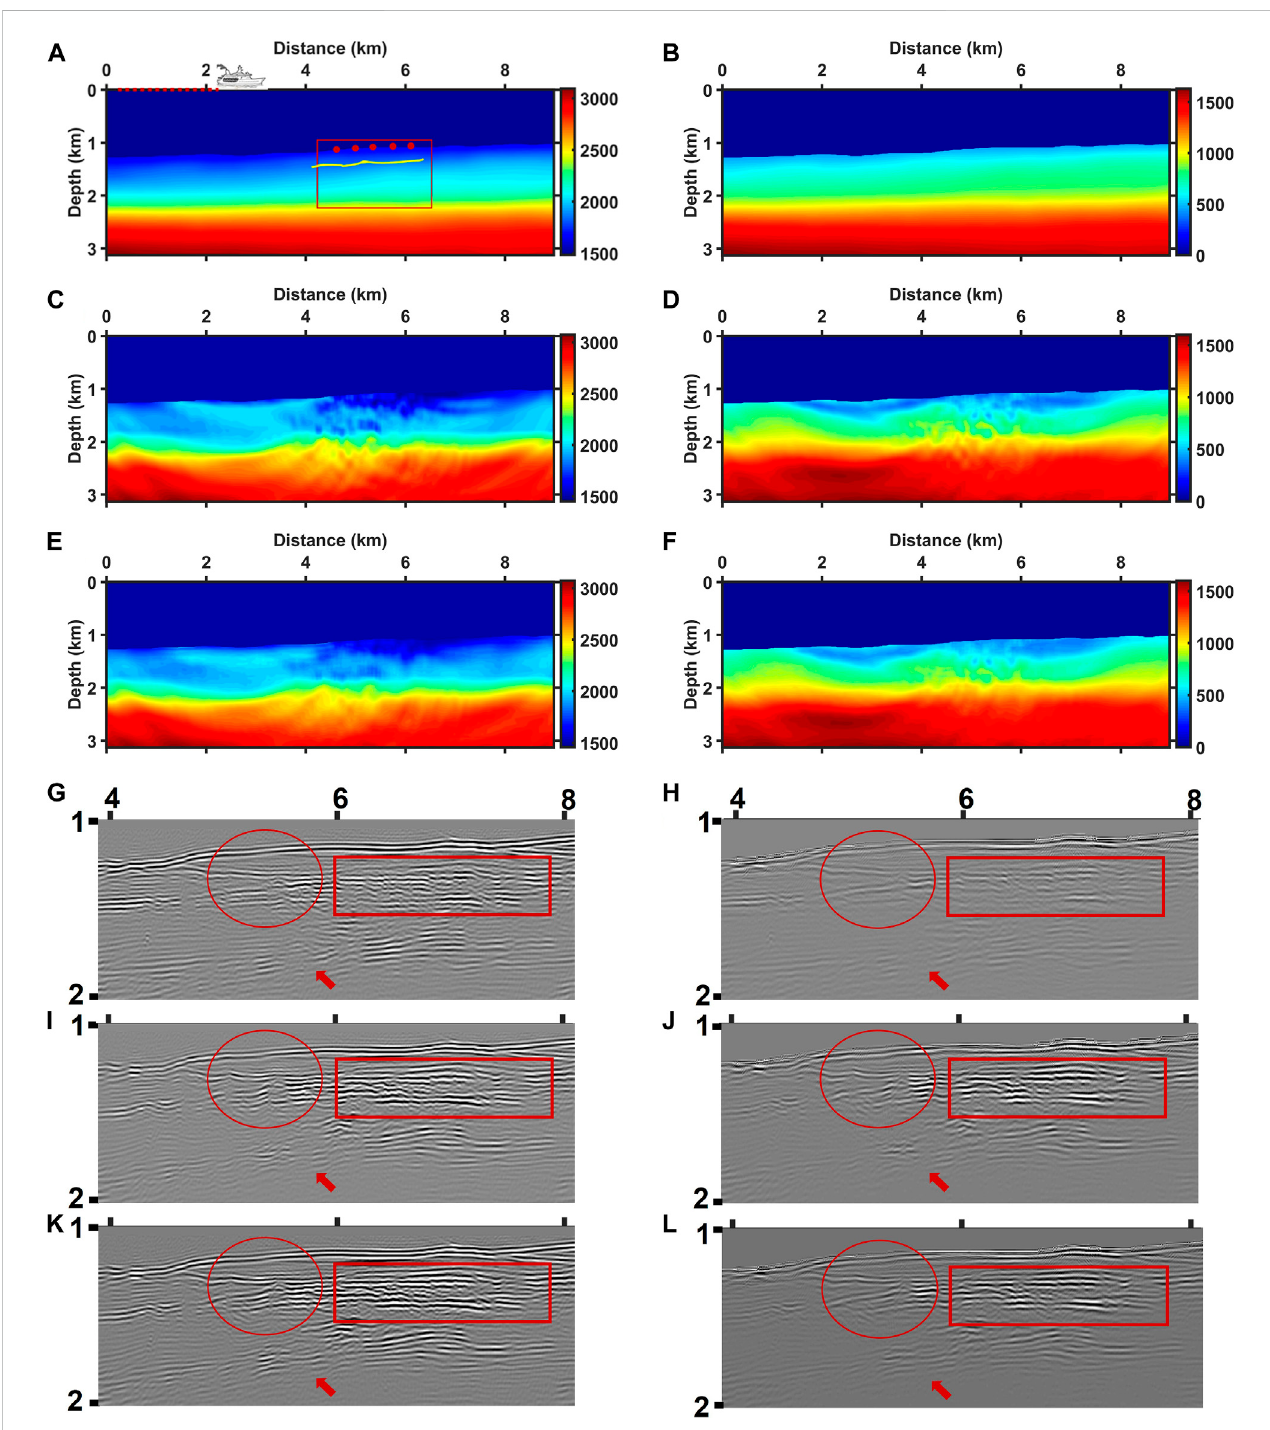
FIGURE 10 The starting P-wave (A) and S-wave (B) velocities; P-wave (C) and S-wave (D) velocities of AEFWI for OBS data; and P-wave (E) and S-wave (F) velocities of J-AEFWI. The dotted line behind the ship indicates the towed streamer, the red balls represent OBS, and the target area is in the red box. The yellow line indicates the free gas layer. The part of images of starting P-wave velocity (G) , starting S-wave velocity (H) , P-wave velocity of AEFWI for OBS data (I) , S-wave velocity of AEFWI for OBS data (J) , P-wave velocity of J-AEFWI (K) and S-wave velocity of J-AEFWI (L) , respectively. The areas indicated by arrows, rectangles and circles show improvements for